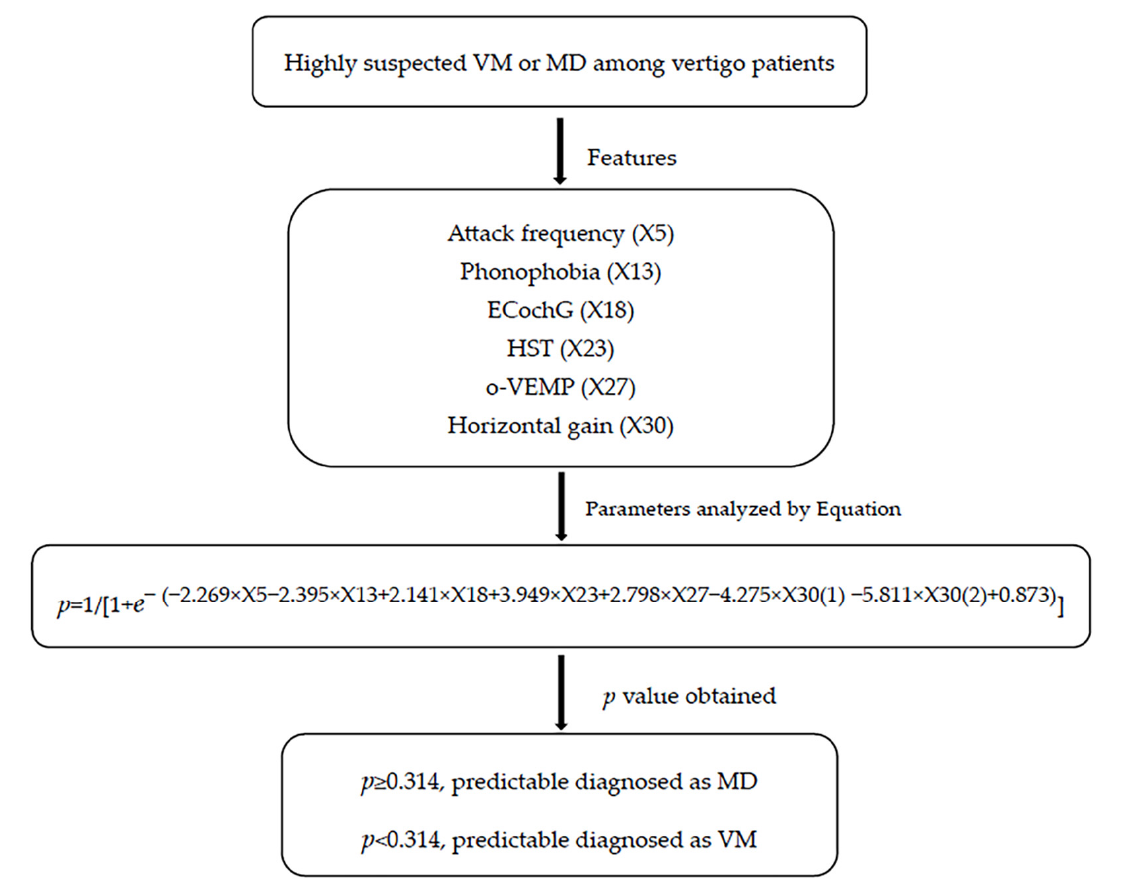
Figure 1. Differential diagnostic flow between VM and MD based on clinical and auditory-vestibular function features. EcochG, electrocochleogram; HST, head shake test; o-VEMP, Ocular Vestibular Evoked Myogenic Potential; VM, vestibular migraine; MD, Meniere’s disease.